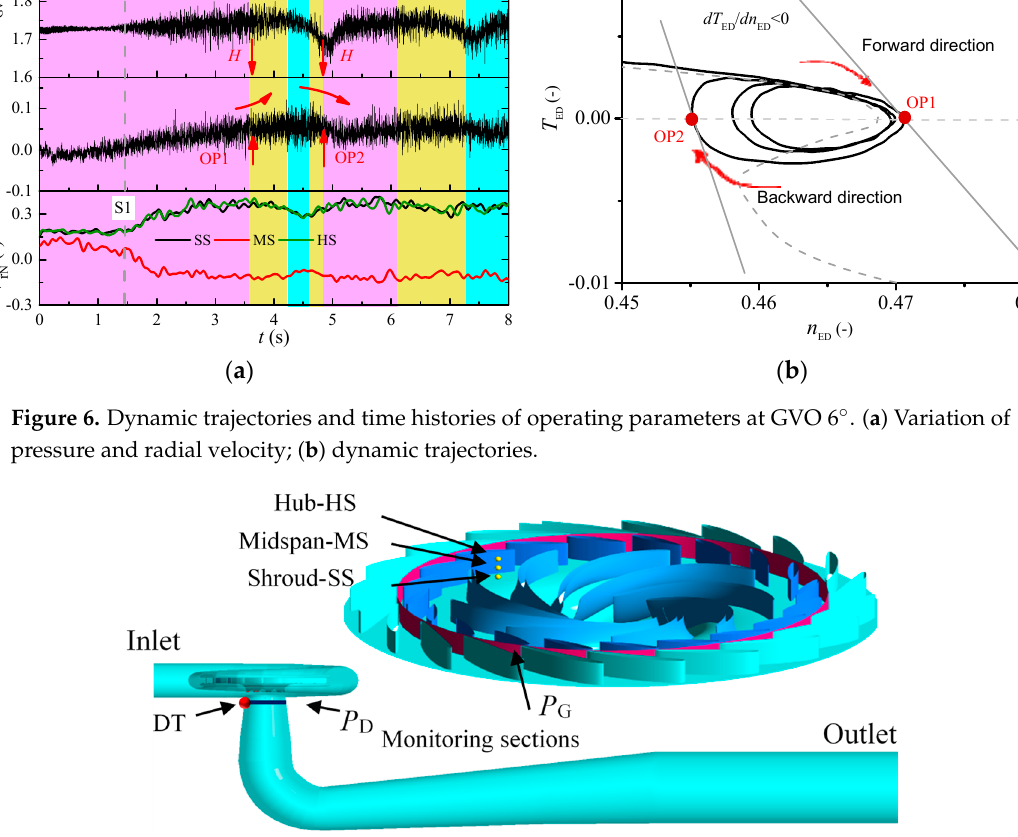
Figure 7. Schematic diagram of monitoring points and sections.